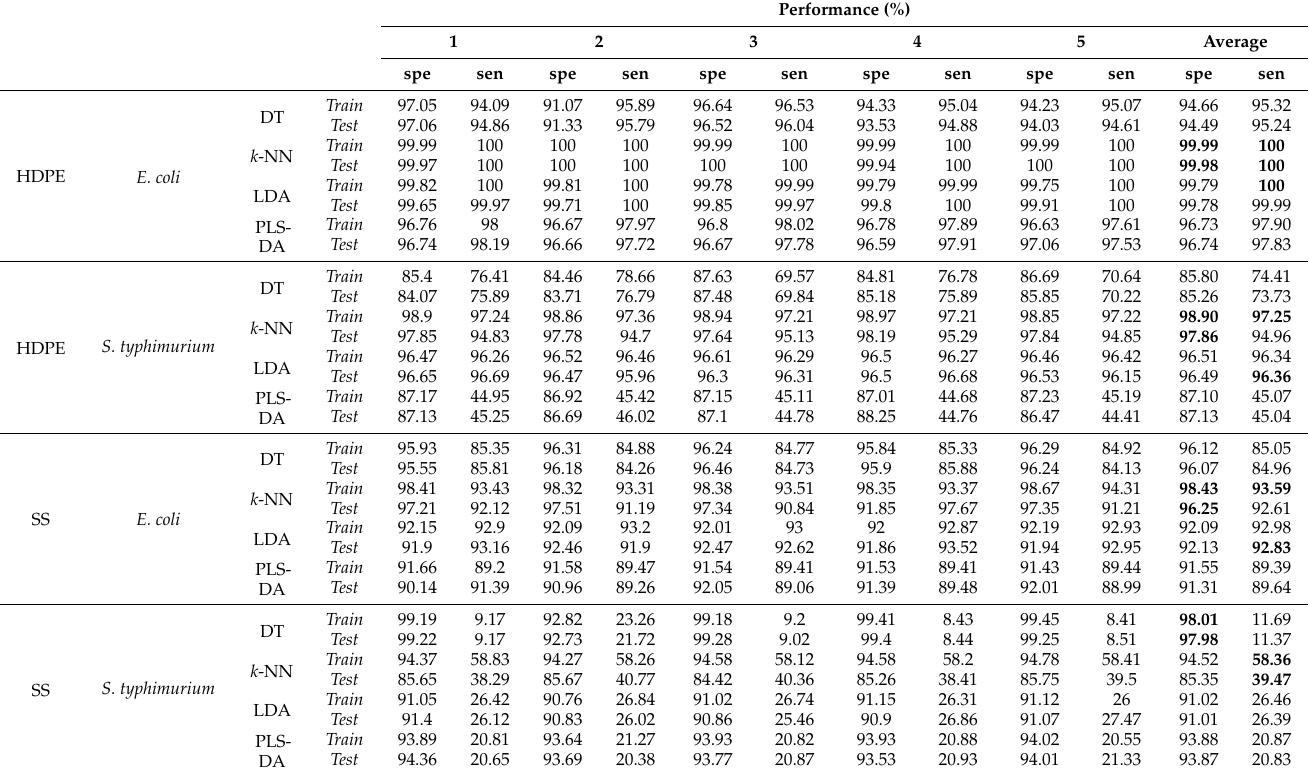
Table 1. Discriminant model